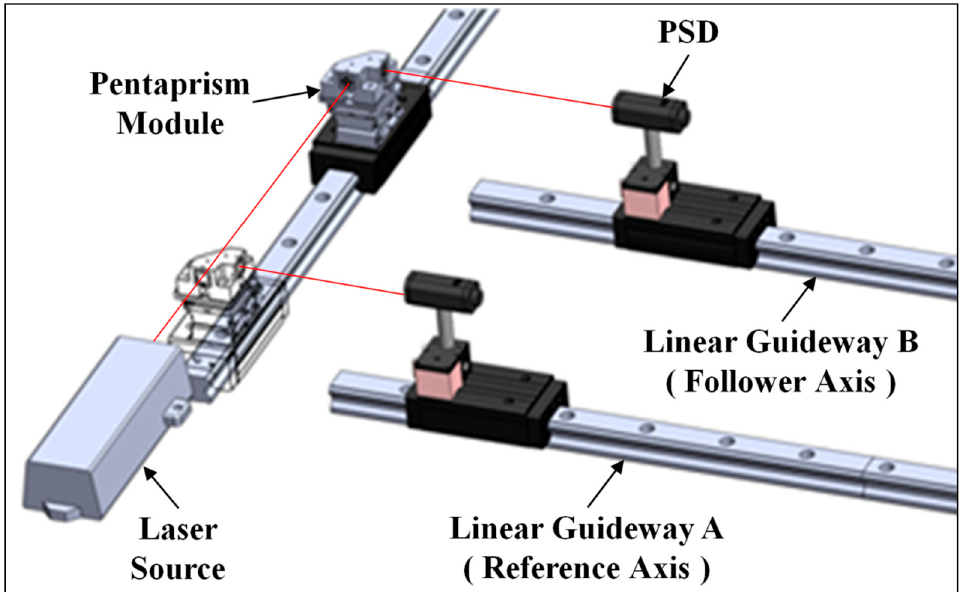
Figure 7. Schematic diagram of the parallelism module.